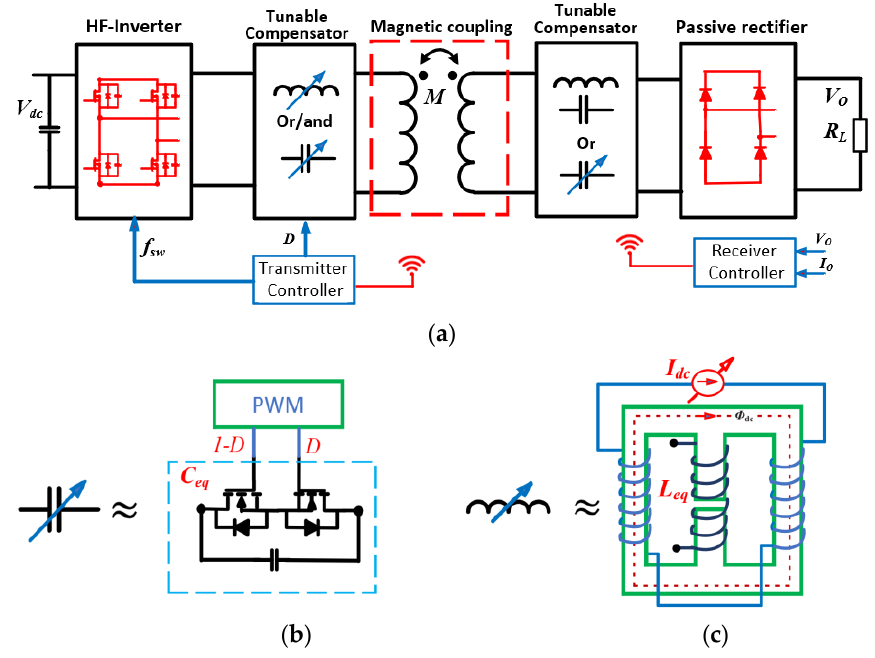
Figure 19. PE structure of tunable compensation networks: ( a ) general PE structure, ( b ) typical tunable capacitor circuit, ( c ) typical tunable inductor circuit.